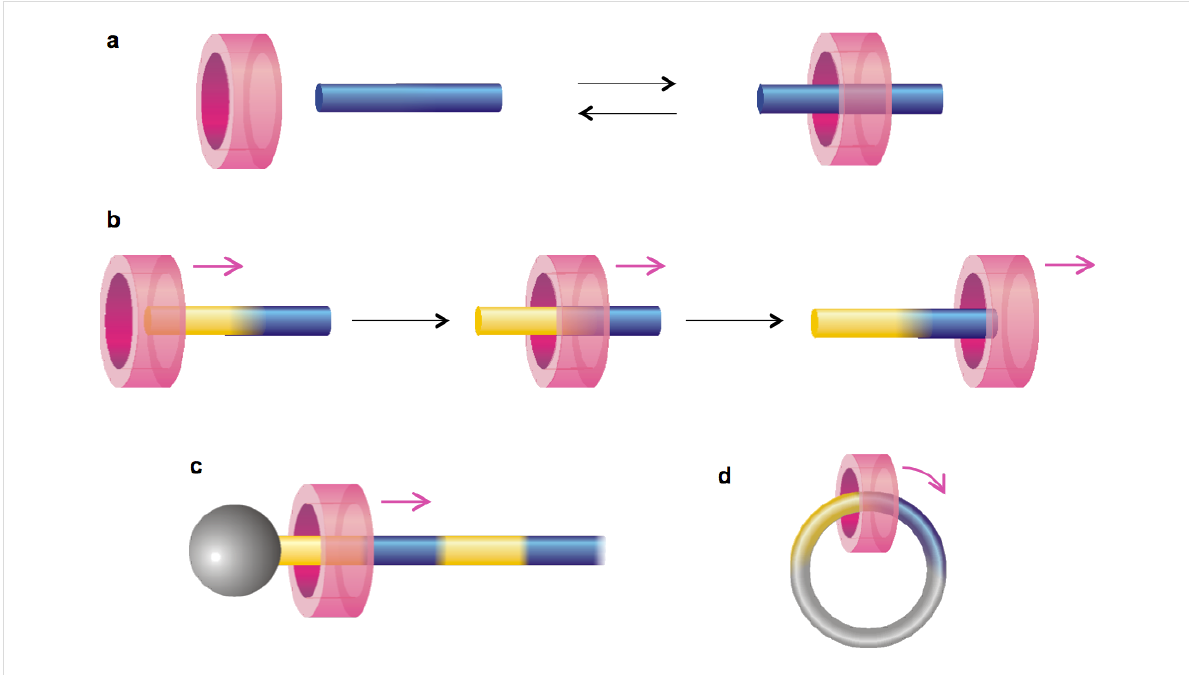
Figure 1: Schematic representation of the threading/dethreading of a pseudorotaxane (a) and of the relative unidirectional transit of a macrocycle along a nonsymmetric molecular axle (b). By incorporating the system shown in (b) in a rotaxane or a catenane, linear (c) or rotary (d) motors may be obtained,